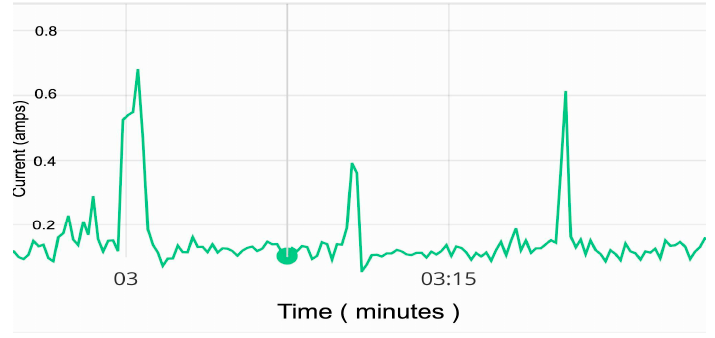
(cid:1855)(cid:1873)(cid:1870)(cid:1870)(cid:1857)(cid:1866)(cid:1872) (cid:1856)(cid:1872) represents total charge where (cid:82) b (cid:3028) current dt represents total charge where a